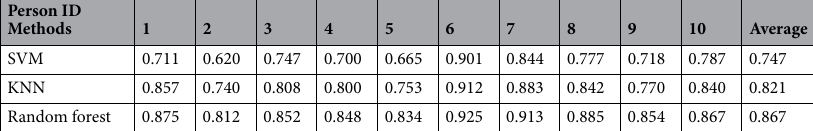
Table 4. Emotion estimation accuracy for SVM, KNN, and random forest methods.